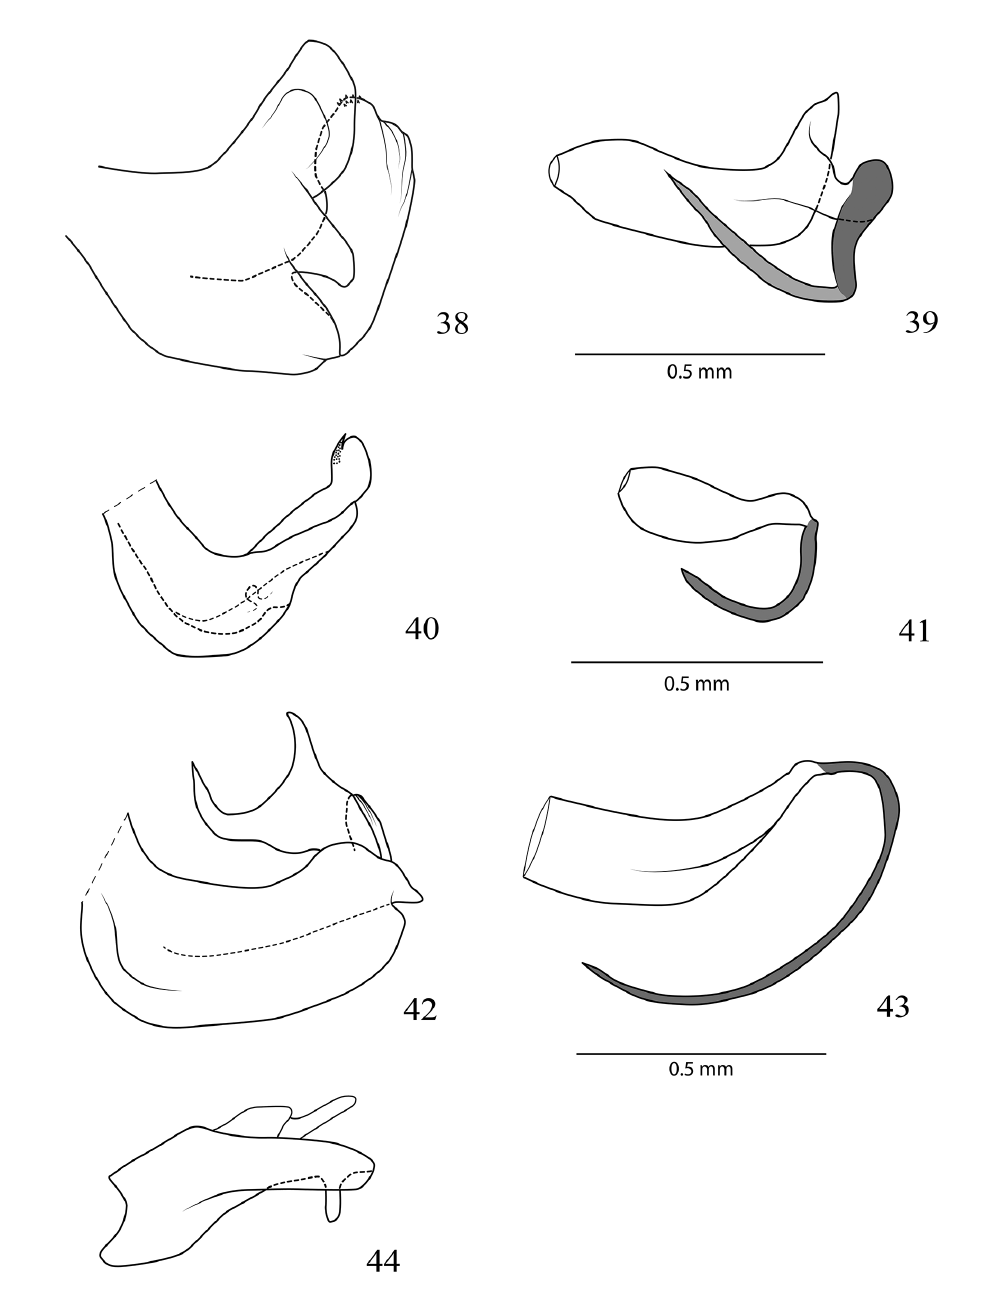
Figs 38–44. Phallic complexes and anal tube. 38–39 . Pitambara triremiprocta Wang & Soulier-Perkins, sp. nov. 38 . Periandrium, lateral view. 39 . Aedeagus, lateral view. 40–41 . Pitambara impudica Wang